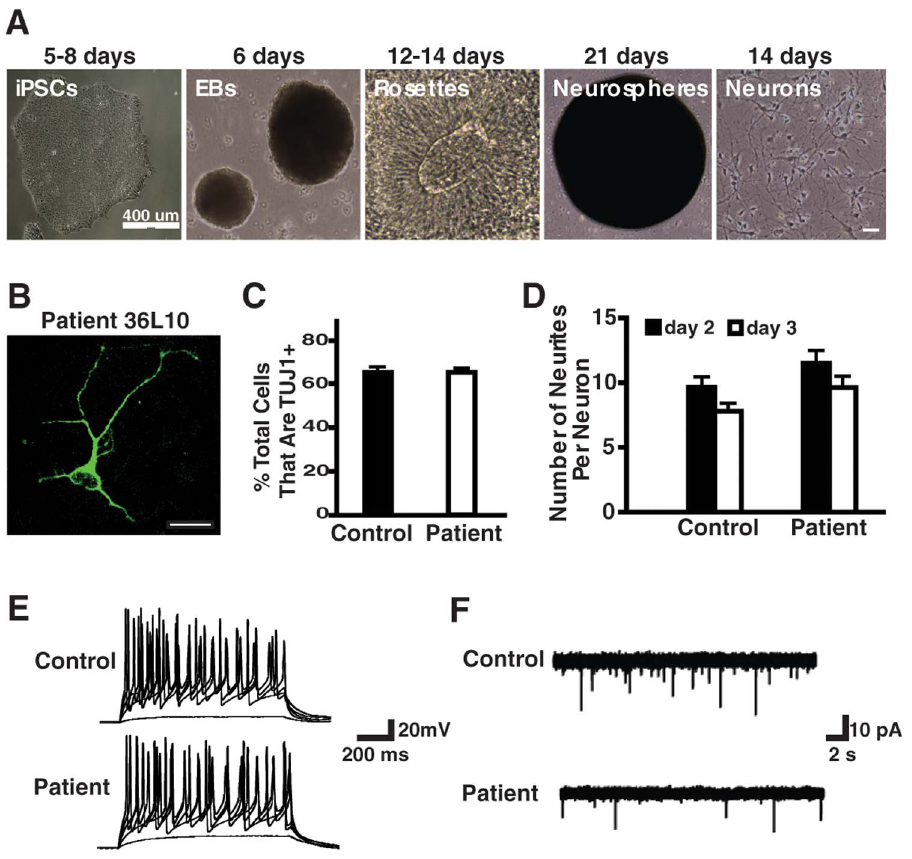
Figure 3. Characterization of iPSC-derived neurons with the TDP-43 A90V mutation. ( A ) Representative images of each of the five stages of the neural differentiation. The numbers of days cells are in each stage are listed on the top of each image. ( B ) Representative image of TUJ1 staining in patient neurons (36L10). ( C ) Percentage of TUJ1 + cells in control and patient neuronal cultures differentiated from iPSC lines 37L20, 37L25, 36L3 and 36L11. ( D ) Number of neurites in control and patient neurons differentiated from iPSC lines 37L20, 37L25, 36L3 and 36L10. ( E ) Sample recording of normal induced action potentials in response to somatic current injections in control and patient neurons differentiated from iPSC lines 37L20, 37L25, 36L10 and 36L11. ( F ) Spontaneous synaptic activity of control and patient neurons differentiated from iPSC lines 37L20, 37L25, 36L10 and 36L11.